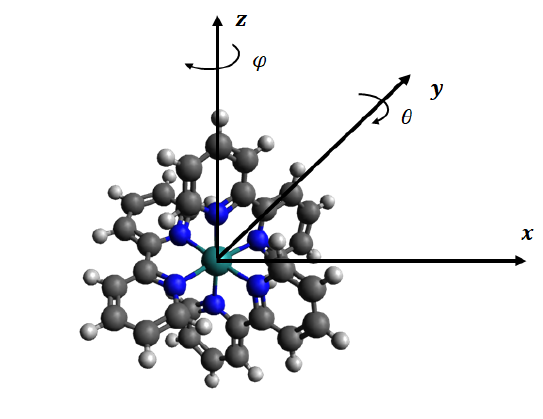
Figure 1. Three-dimensional structure of Ru(bpy) 2 + six nitrogen atoms (N) in blue; carbon atoms (C) in black, and hydrogen atoms (H) in